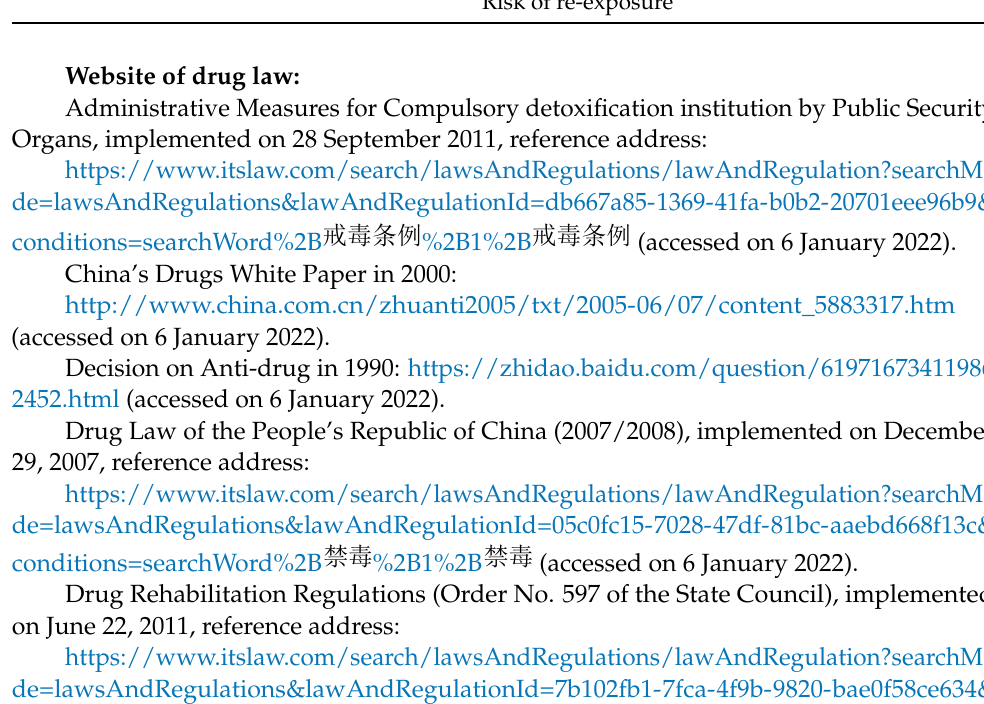
Table A3. Recoding by context and genera.